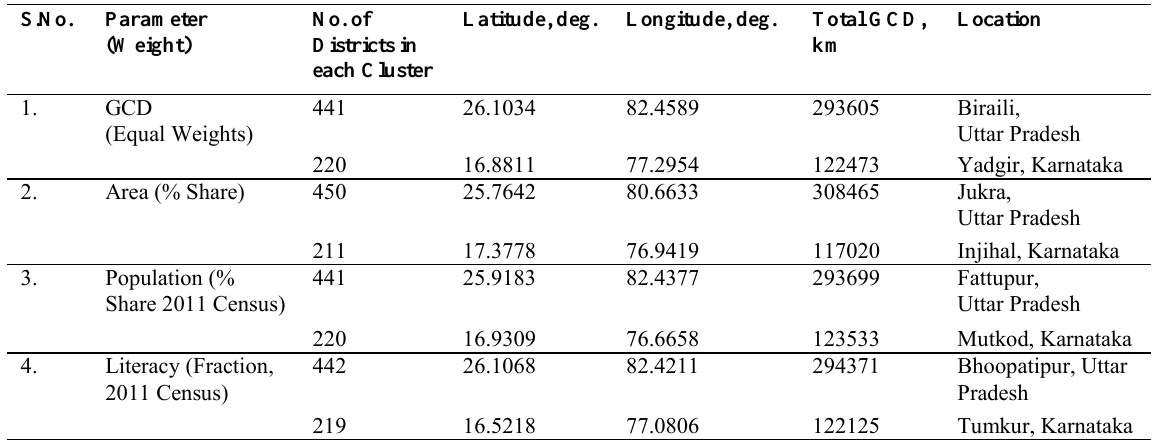
Table 4 Districts wise Analysis – Two Optimal Facility Locations